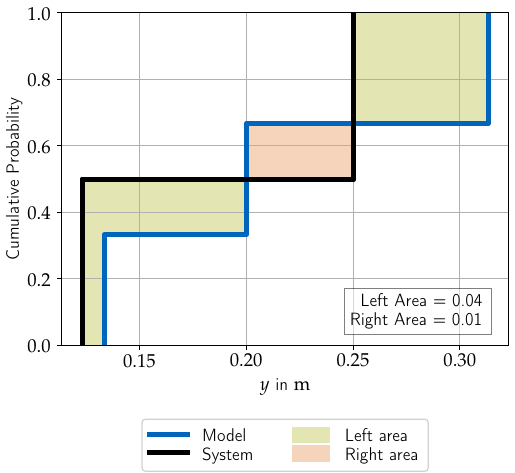
Figure 6. Area validation metric at the exemplary validation scenario v x = 118km/h and a y , ref = 0.65 a y , smax . The left and right areas refer to the perspective of the model with the · system on its left or right